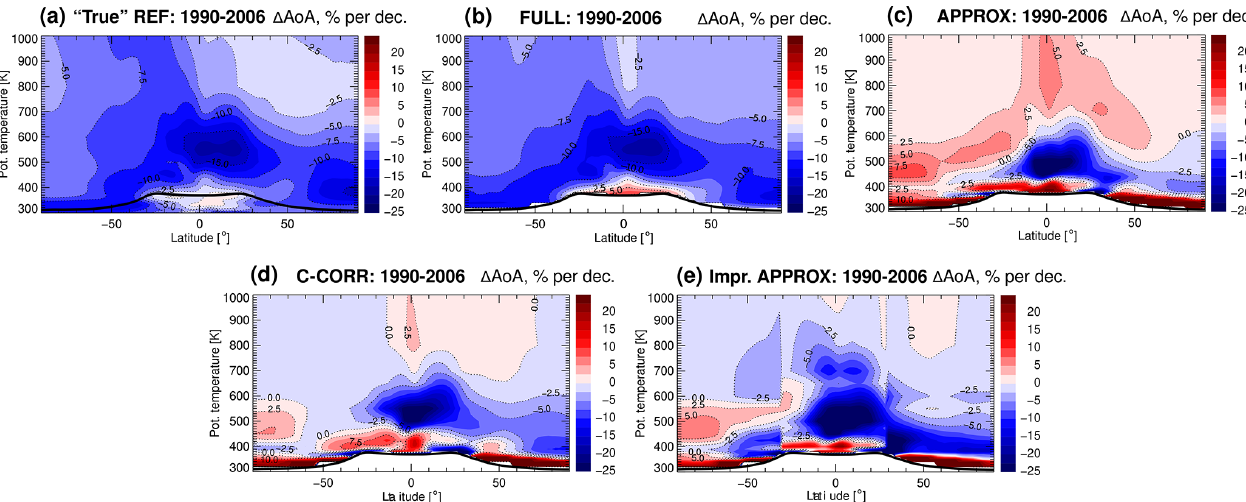
Figure 6. Decadal changes of AoA during 1990–2006: true and full. Comparison of decadal AoA trends for the 1990–2006 period, esti- mated using different methods: (a) true AoA trend from CLaMS simulation driven by ERA-Interim reanalysis, (b) FULL, (c) APPROX, (d) C-CORR (stratospheric entry H 2 O and CH 4 propagation by CLaMS age spectrum and a constant AoA–FRF correlation), and (e) improved approximation method (stratospheric entry H 2 O and CH 4 propagation by the parameterized age spectrum and a constant AoA–FRF correla- tion). The AoA trends are presented in percentage per decade with respect to the 1990–2006 AoA climatology from the respective method. The black line is the climatological 1990–2006 tropopause calculated from ERA-Interim.